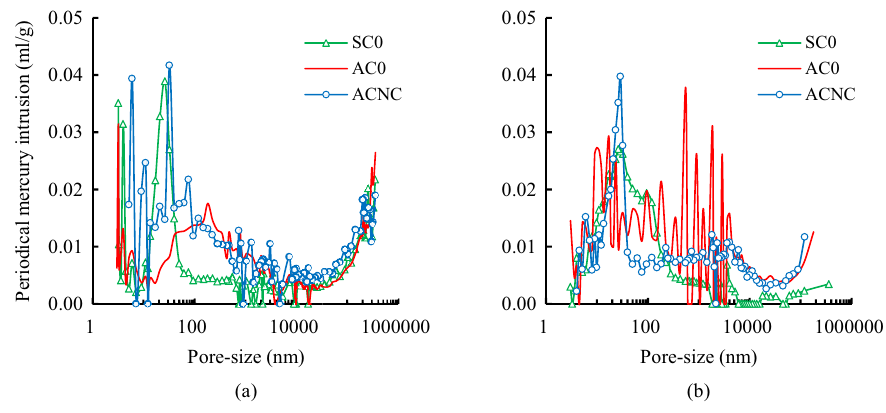
Figure 7: Pore - size distribution of di ff erent concrete samples ( a ) 28 d ( b ) 300 d.